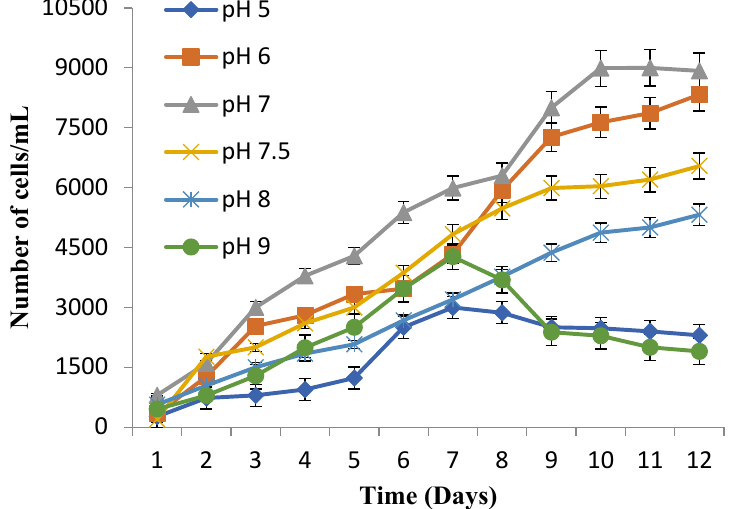
Figure 3. Growth observations of Paramecium multimicronucleatum culture provided with different pH.